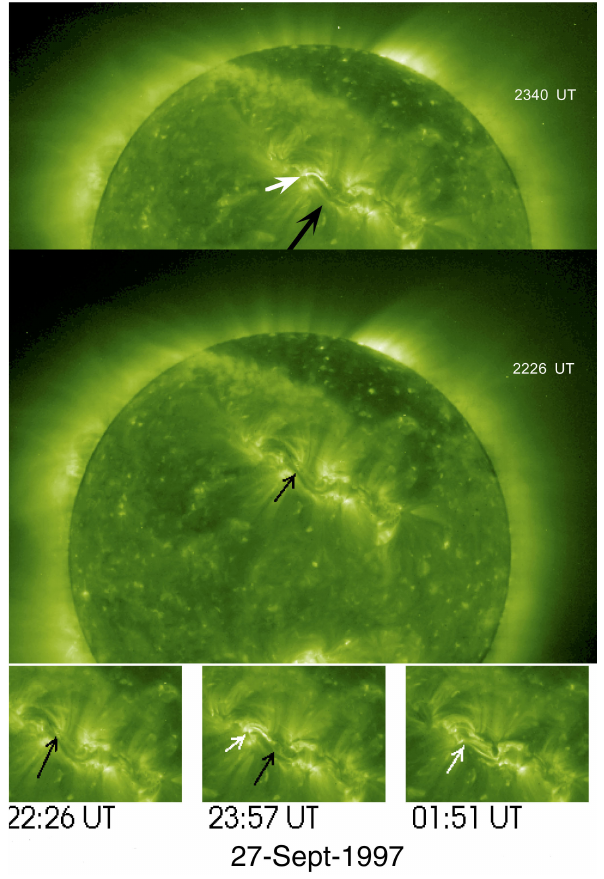
Plate IIb: In the middle image of the Sun (UVI 195 ˚A iron line) the black arrow shows filament and filament channel before erup- tion (22:26UT, on 27 September 1997, Event 14). The black arrow in top image shows the enlarged, shadow-like shape of the erupted filament, and the white arrow points to a bright new arcade forma- tion (23:40UT). Bottom, from left to right the sequence shows in the right panels a more advanced stage of eruption at 23:57UT on 27 September, and the long arcade formation created after filament eruption, at the time of the halo-CME ( ∼ 01:50UT, 28 September).